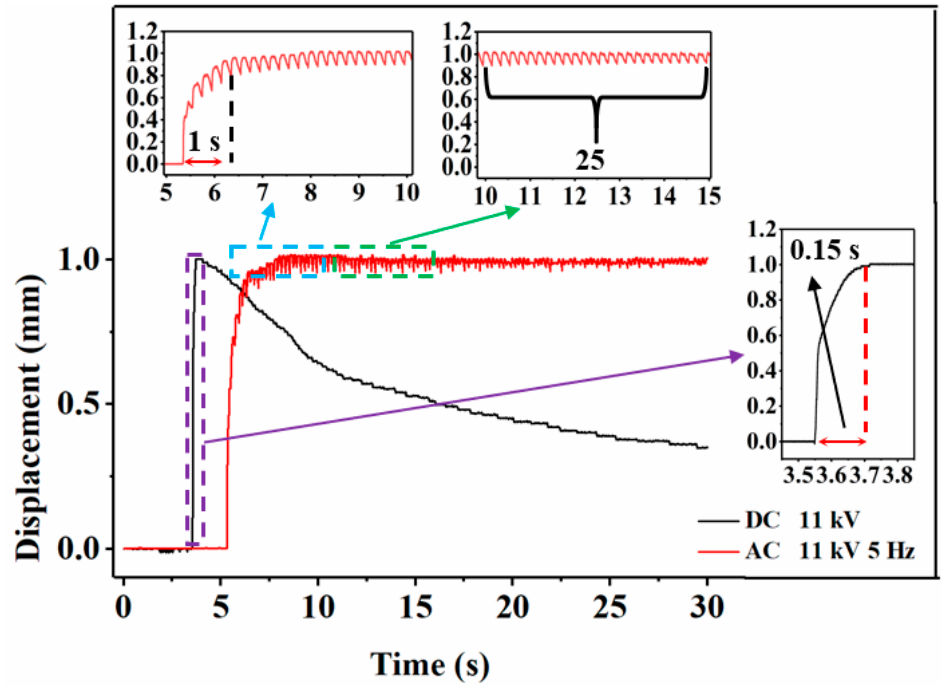
Figure 6. The output characteristics of the actuator under DC and AC voltages are compared.